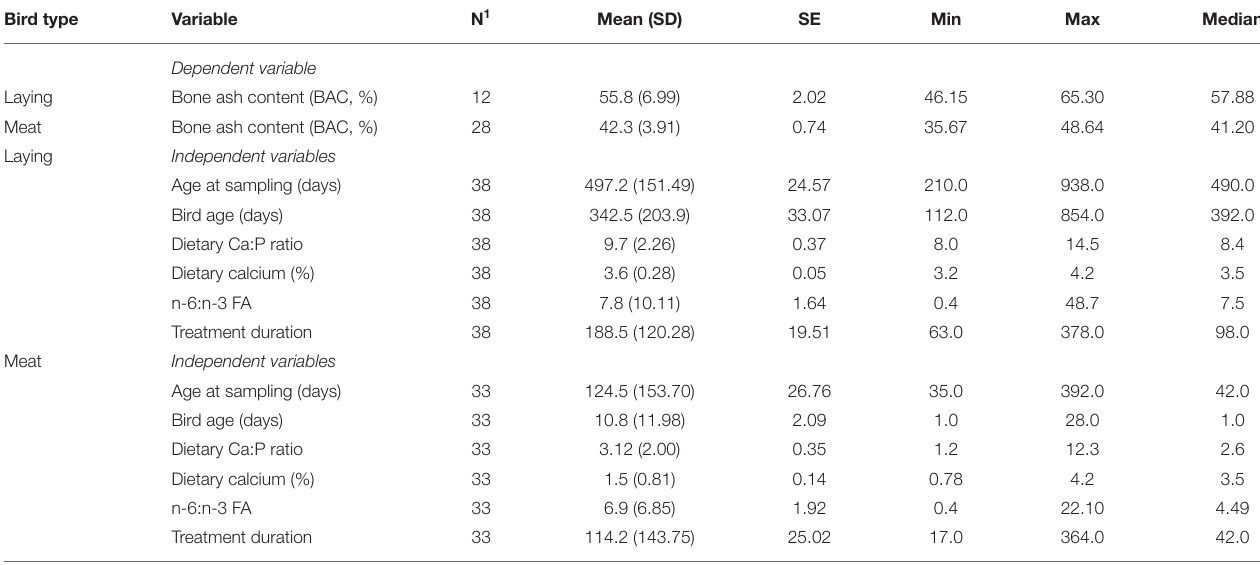
TABLE 2 | Descriptive statistics of bone ash content (BAC, %) and independent variables (treatment duration (days), bird age (days), age at sampling (days), dietary calcium to phosphorus ratio, dietary n-6:n-3 ratio, and dietary calcium concentration (%) in the dataset. Bird